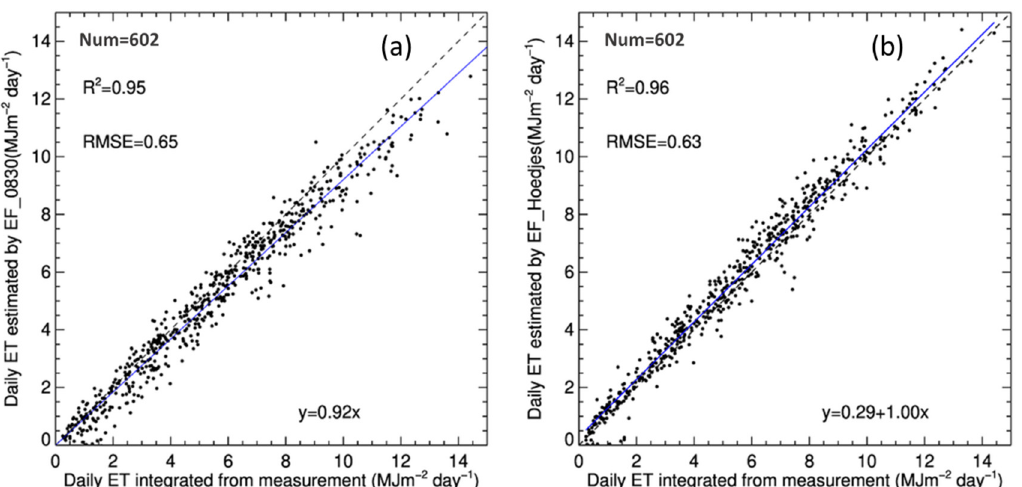
Figure 8. The measured daily integrated ET flux plotted against the estimated results by ( a ) constant EF assumption set to 10:30 LT and ( b ) corrected EF by Hoedjes method. The black dash line is 1:1 reference line and the blue line is the linear fit line.